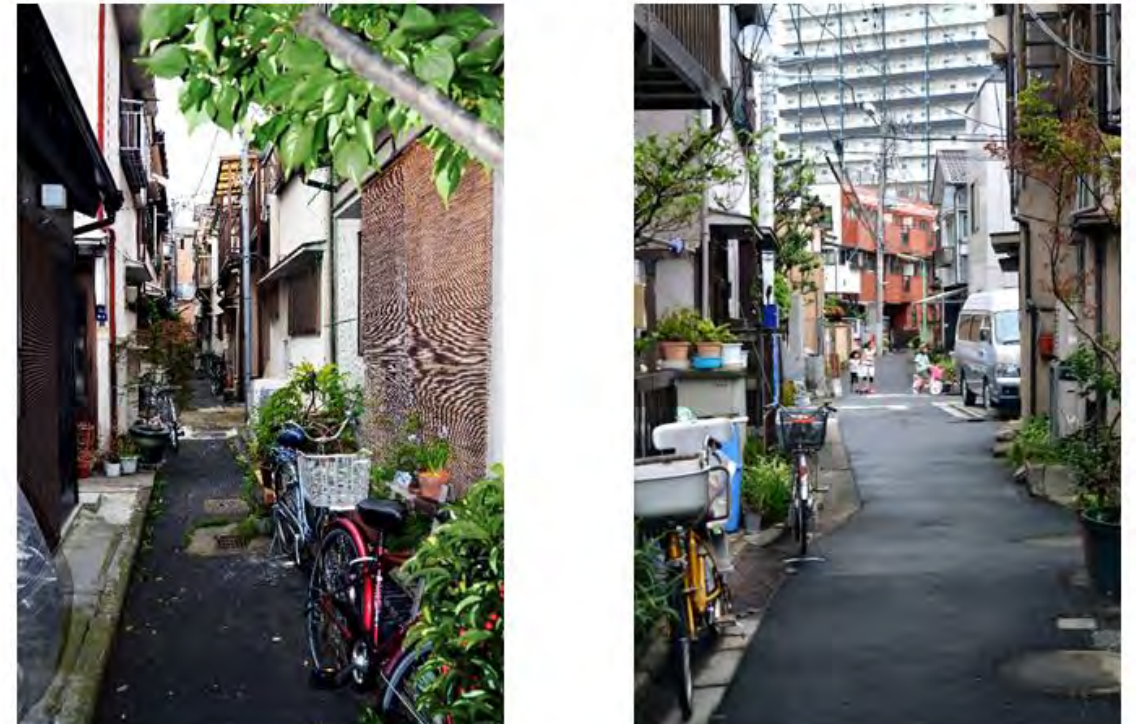
Figure 3. (a) Narrow alley. Photo by author. (b) Juxtaposition. Photo by author.